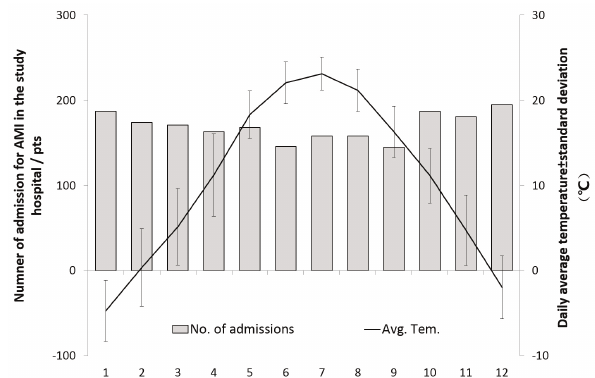
Figure 1: Acute myocardial infarction (AMI) hospitalized cases accor- ding to